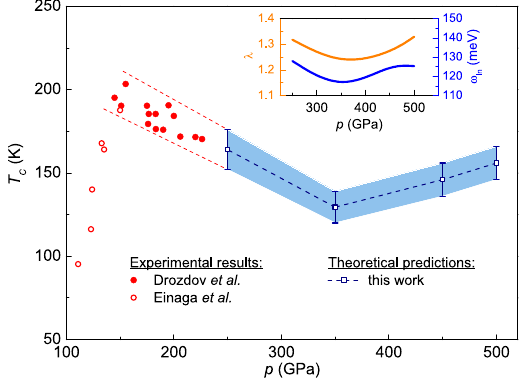
Figure 6. The critical temperature as a function of the pressure. The theoretical results were obtained in the framework of the Eliashberg formalism with commonly accepted value of the Coulomb pseudopotential, µ = . ⁎ 0 13 . The error bars indicate the value range of T µ ∈ . . ⁎ C with constant and the logarithmic phonon frequency on the pressure.